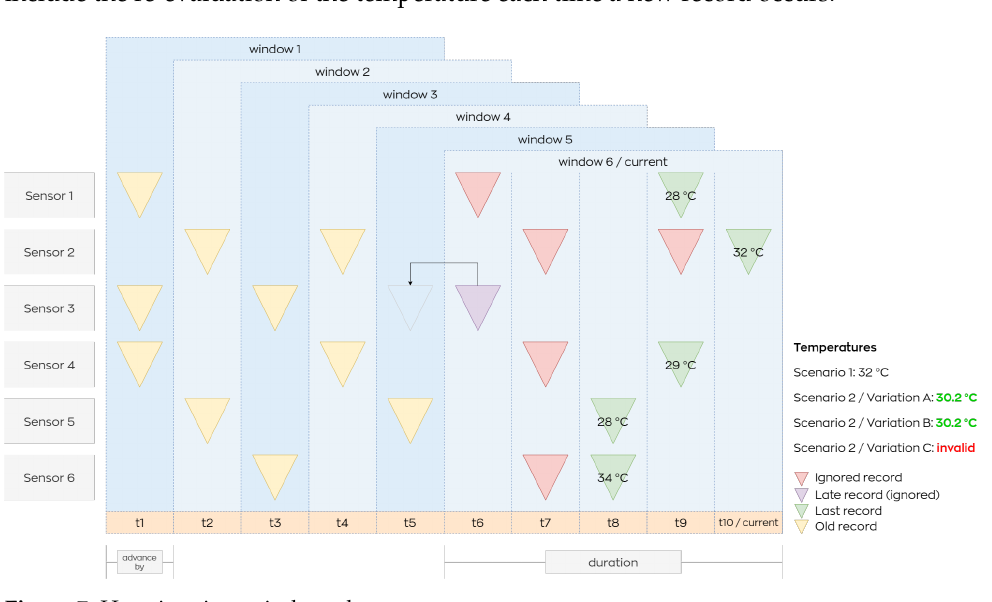
Figure 7. Hopping time windowed event